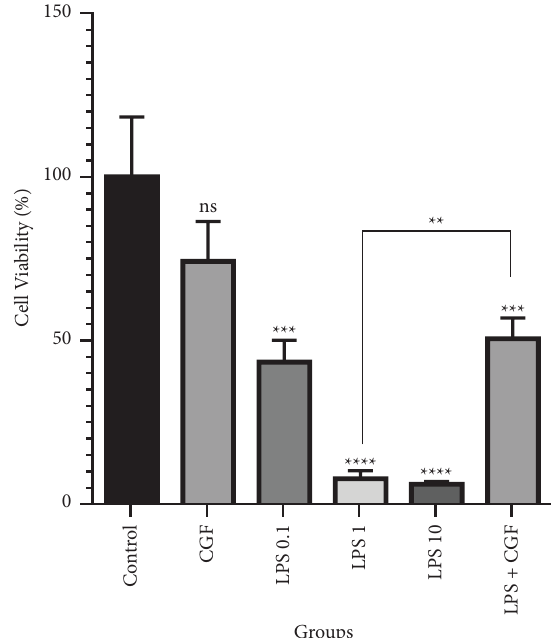
Figure 4: MTT assay for cell viability after 21 days of treatment. Exposure of dental pulp stem cells (DPSCs) to lipopolysaccharide (LPS) combined with concentrated growth factor (CGF) increased the cell viability rates remarkably more than LPS treatment alone; ∗∗∗∗ p < 0 . 0001, ∗∗∗ p < 0 . 001, ∗∗ p < 0 . 01, and ns �